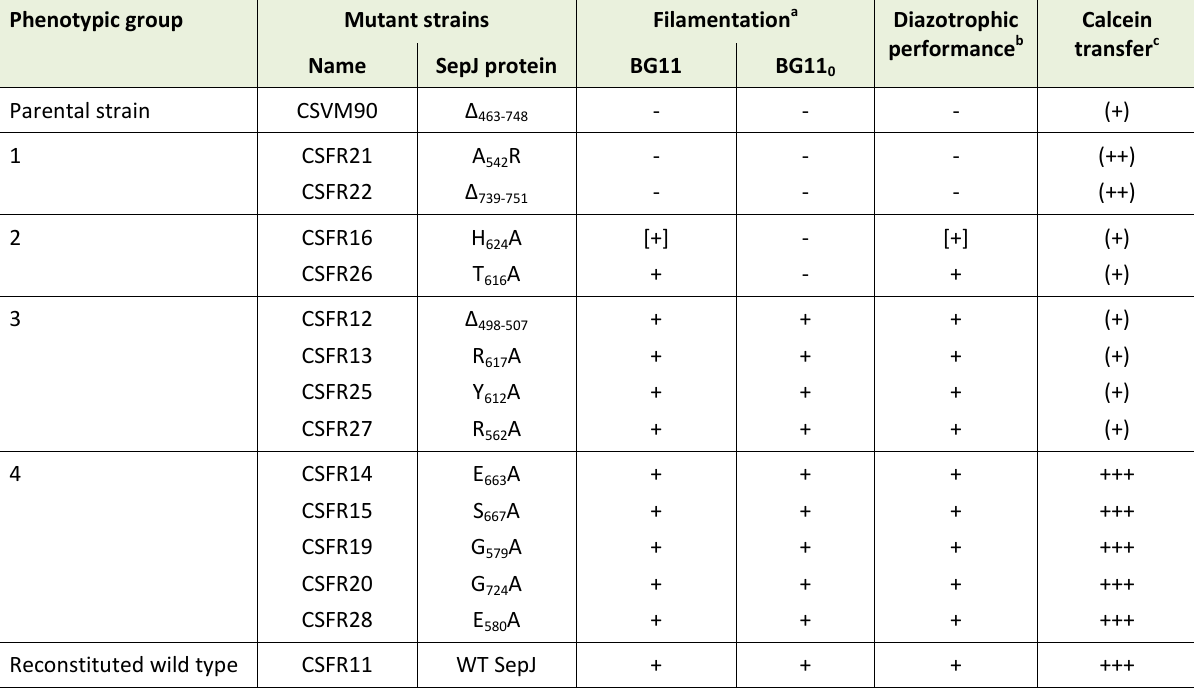
a Data from Fig. 3: +, normal filament length; [+], intermediate filament length; -, extensive filament fragmentation.